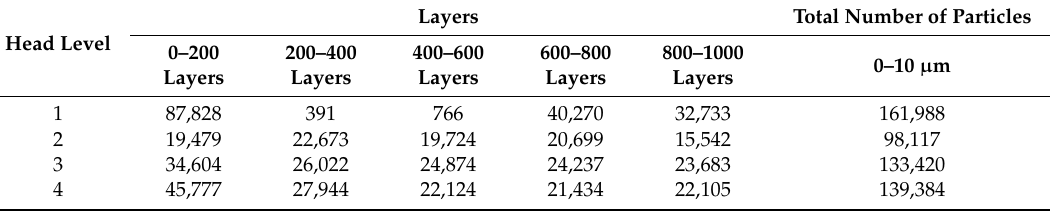
Table 15. Variation in the number of fine particles percolated with the 70% fine particle content (0–10 µ m).